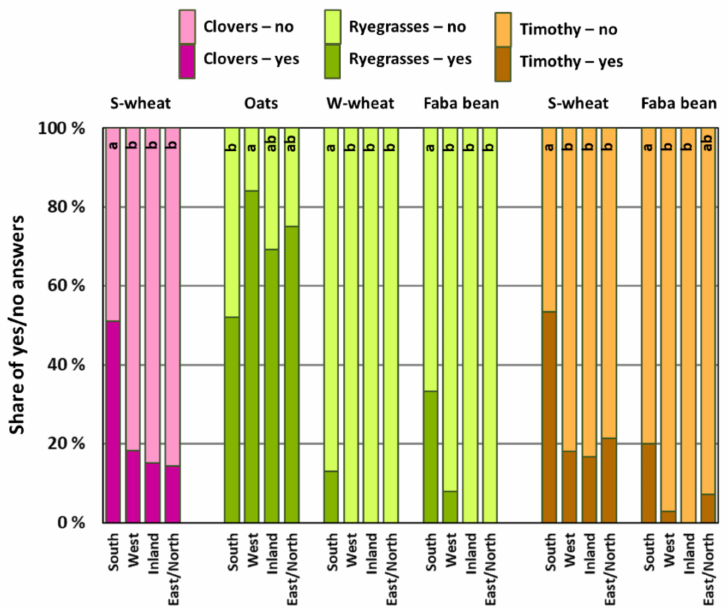
Figure 2. Impacts of the region on cash crops and under-sown cover crop (CC) group combinations in Finland. Only significant differences with p -value ≤ 0.05 are shown. Means with the same letter for each region and CC-cash crop combination do not differ